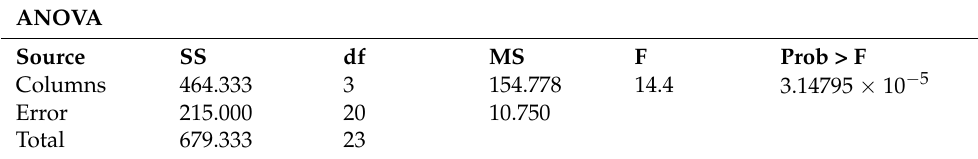
Table 5. ANOVA description of Descending Order of Health